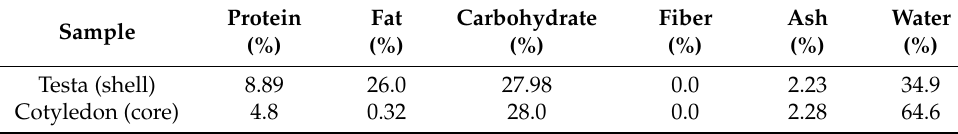
Figure 1. The fermented CCN51 cocoa bean. A cross-sectional view of the bean after 7 days of fermentation. Table 1. The proximate composition of the Ecuadorian echo type of cocoa